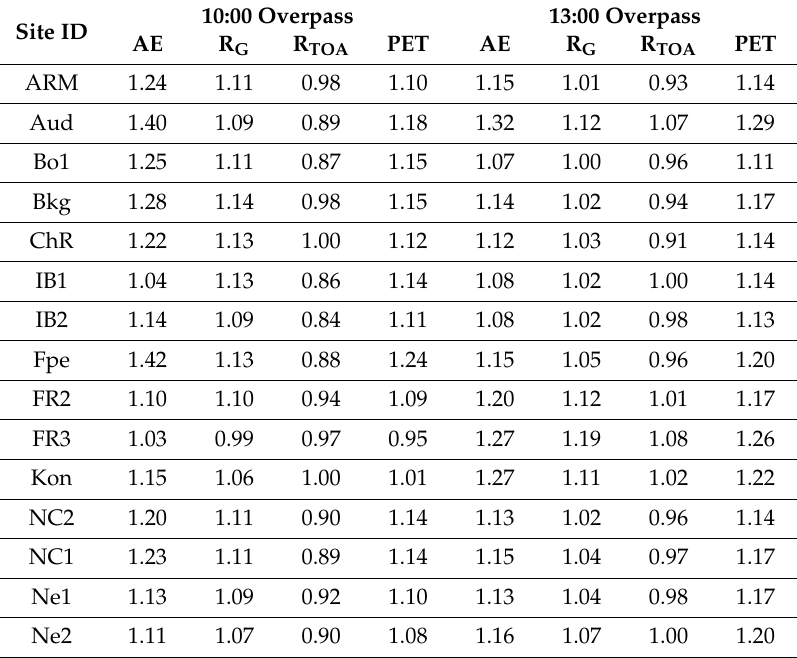
Table A1. β factors derived from observations made at 10:00 and 13:00 for each site and different reference scaling fluxes: the available energy (AE), surface solar radiation (R G ), simulated top-of-atmosphere solar radiation (R TOA ) and potential evapotranspiration (PET). The AmeriFlux site ID labels are defined in Table 2. Two agricultural sites near Mead, NE (i.e., Ne1 and Ne2) represent irrigated